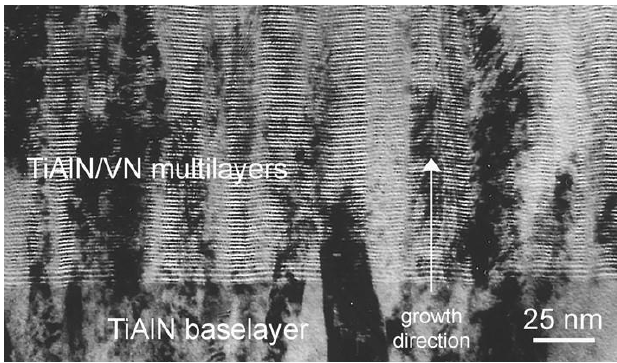
Figure 5. Bright field CTEM image of the nanoscale multilayer structure TiAlN/VN coating.